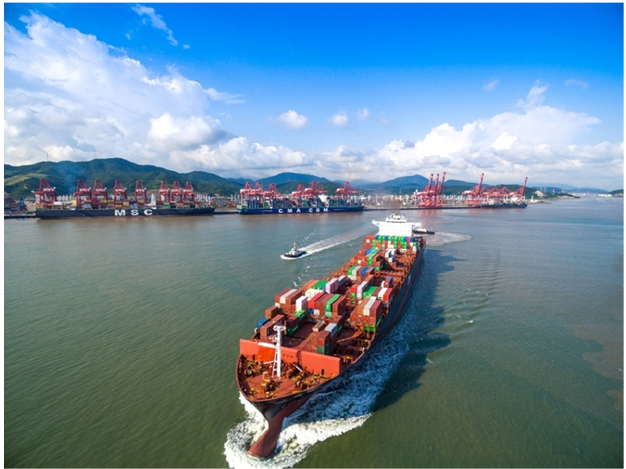
Figure 1. Zhoushan Port during operation.